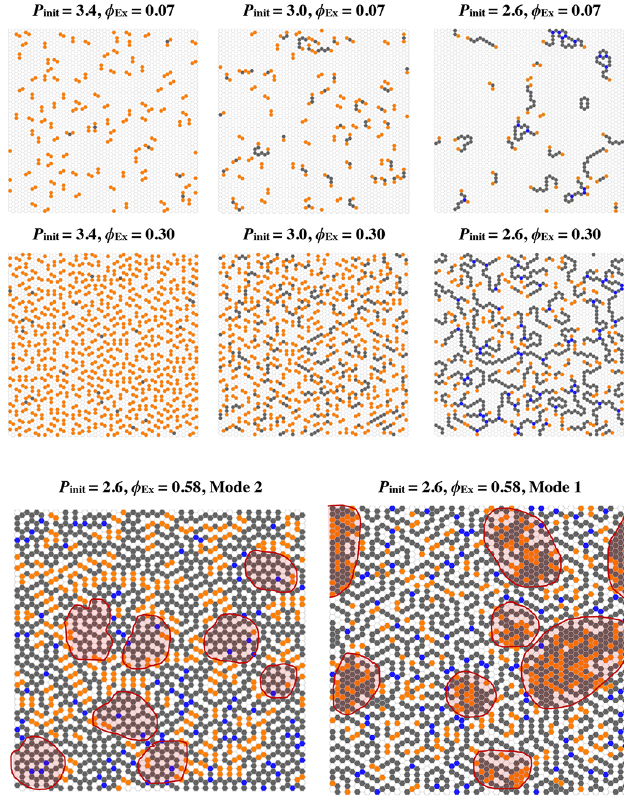
Fig. 16. Two-dimensional image derived from Monte-Carlo-like simulation dependent on the initial packing parameter and the volume fraction of aggregated extractant. Calculations were carried out at x =[U]/[Ex] =0.35 and the bending constant was set to k * =2 k B T/extractant. Below, the simulation was carried out in two different ways to point out the Onsager transition. Mode 2 describes the general procedure used in simulations above, where the total mismatch of the system is minimized. Minimiza- tion by Mode 1 minimizes the number of mismatches, in order to point out the regions of strong mismatch free